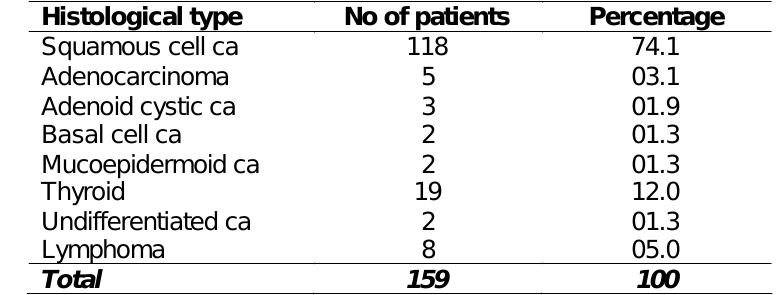
Fig.2 : Malignancies of Pharynx Table II : Histological type